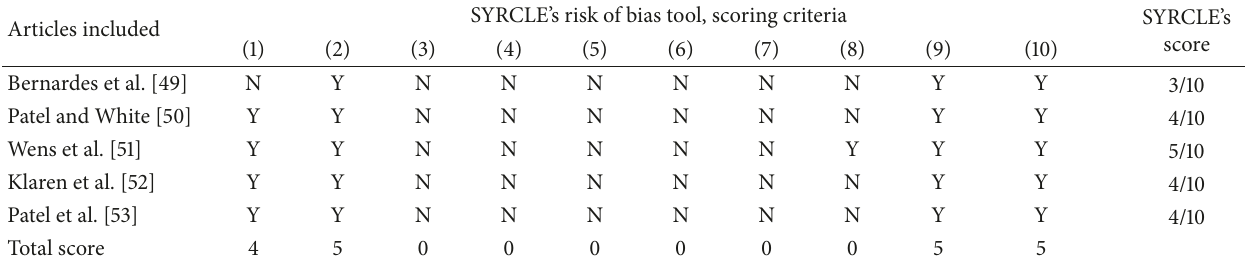
Table 2: Methodological quality assessment of the animal studies included in this